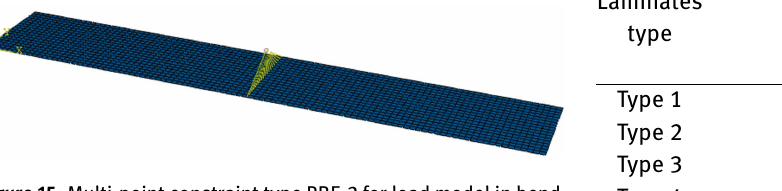
Figure 15: Multi-point constraint type RBE-2 for load model in bend- ing test